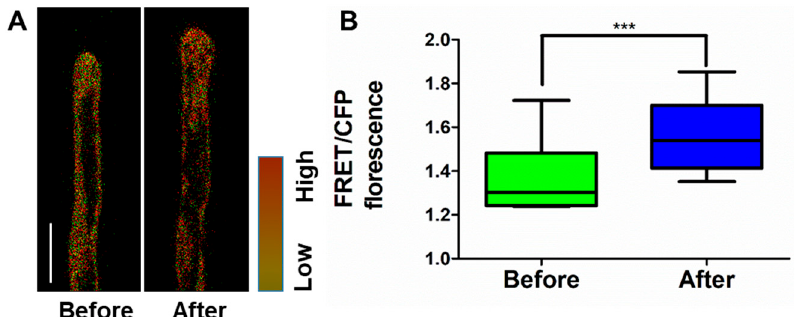
Figure 5. K + application influences the cytoplasmic Ca 2 + level at root hair tips: ( A ) 100 mM KCl treatment induces the increase of cytoplasmic Ca 2 + level in root hairs. Root hairs from wild-type expressing the Ca 2 + sensor YC3.6 were imaged. The red channel represents the intensity of FRET and the green channel represents the intensity of CFP. Bar = 20 µ m. Before, root hairs before treatment. After, swelling structures formed at the root hair tips within 5 min after treatment; ( B ) Quantitative analysis of cytosolic Ca 2 + growing root hair from the wild-type. Bars represent the average length (mean ± s.d.) of six hairs (Student’s t -test, between seedlings before and after treated; *** p < 0.001).